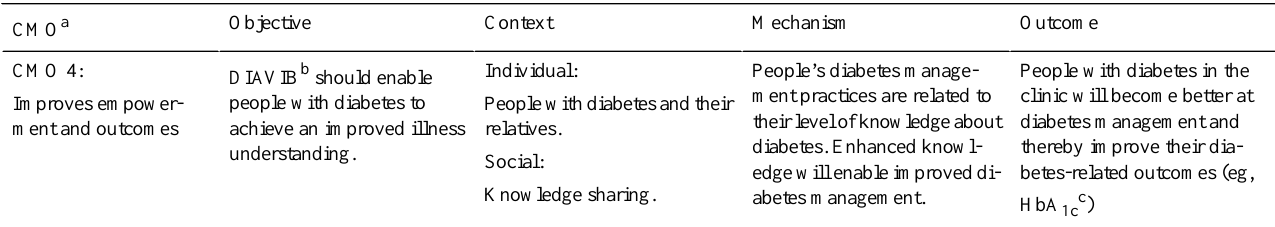
Table 5. Context-mechanism-outcome configuration 4: Diabetes Viborg improves empowerment and clinical